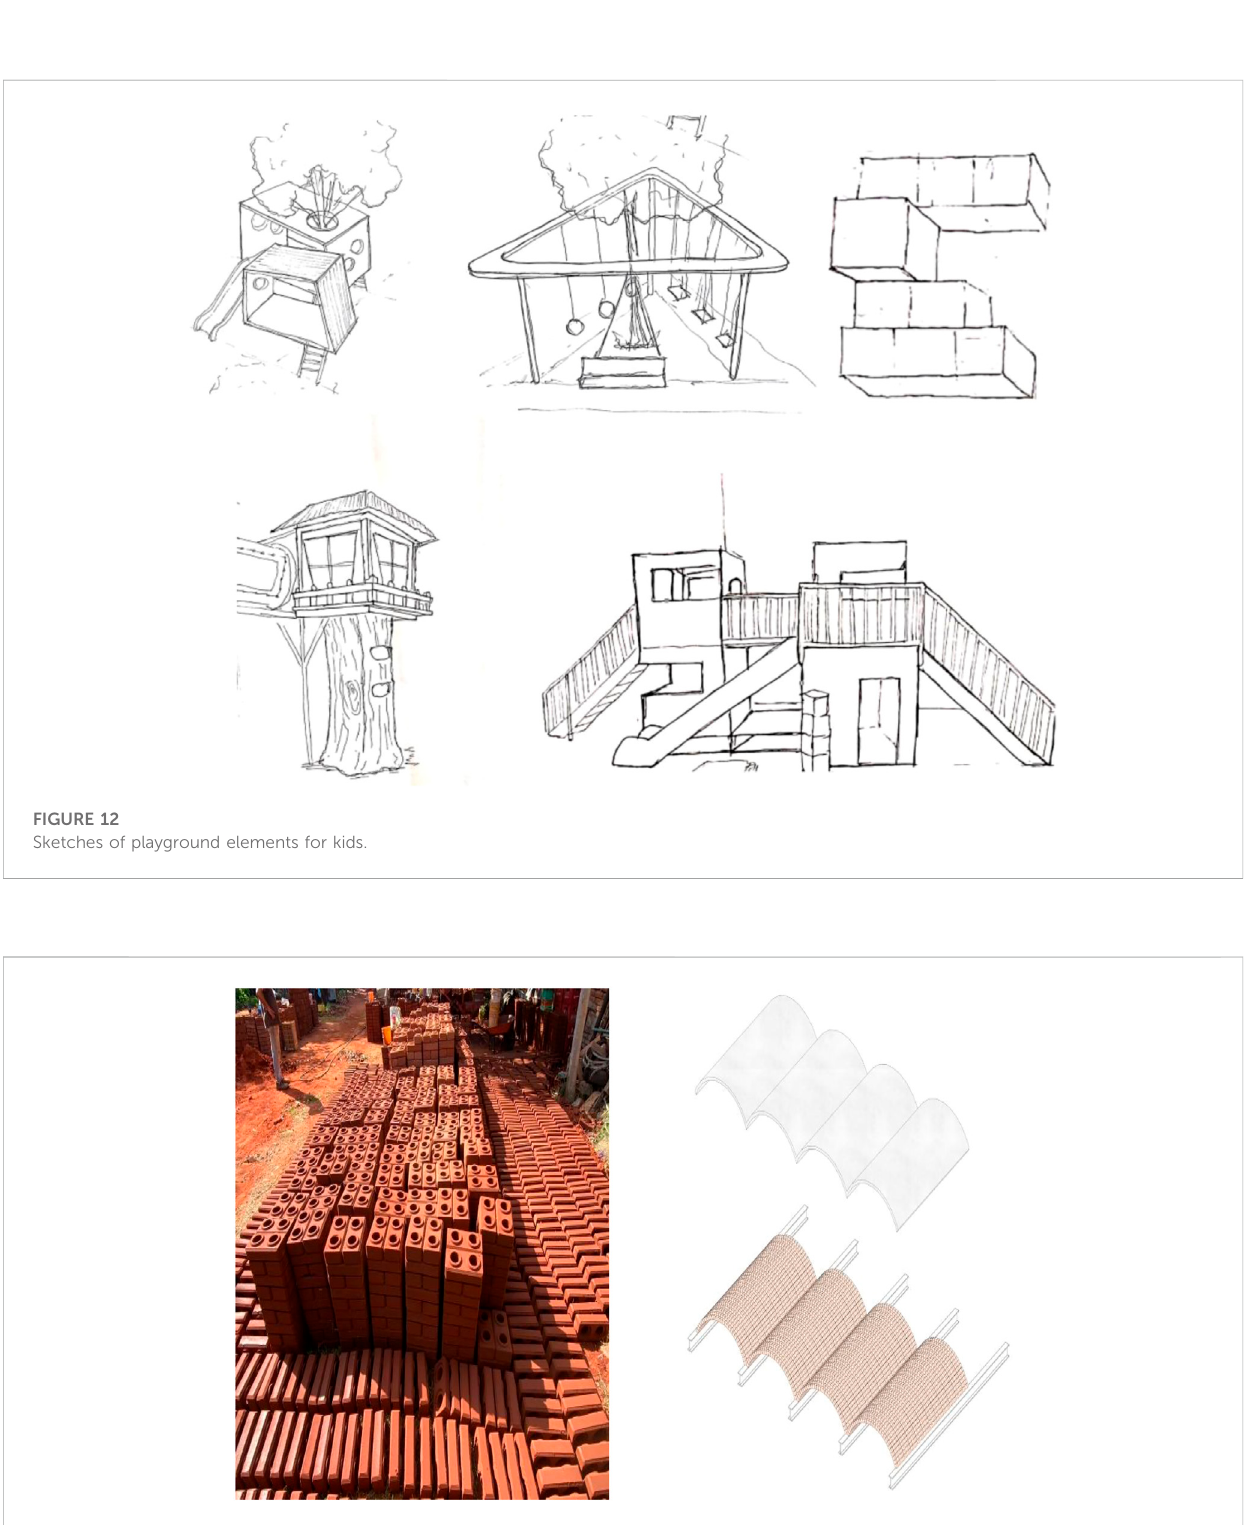
Compressed earth block sections — construction and material